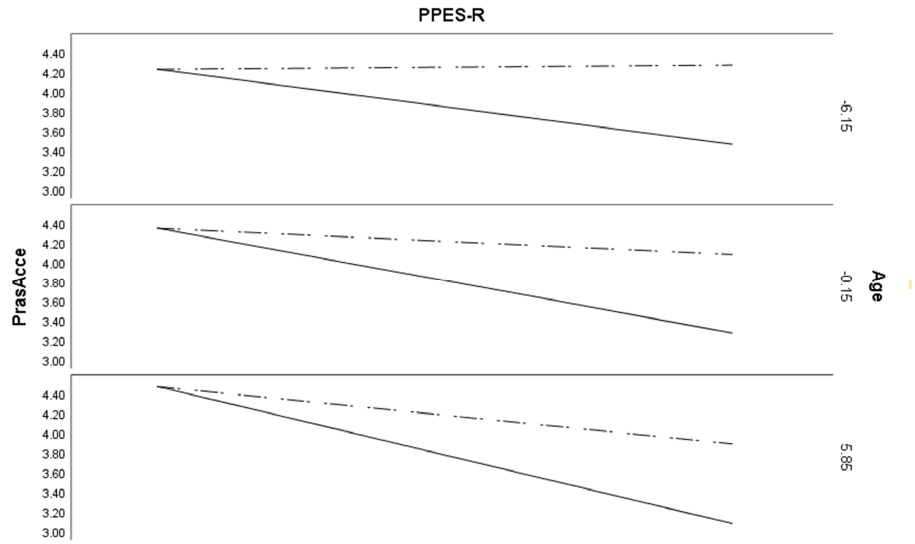
Figure 2. Acceptance of pregnancy, moderation effects. The dashed line represents multiparous women and the solid line represents primiparous women.